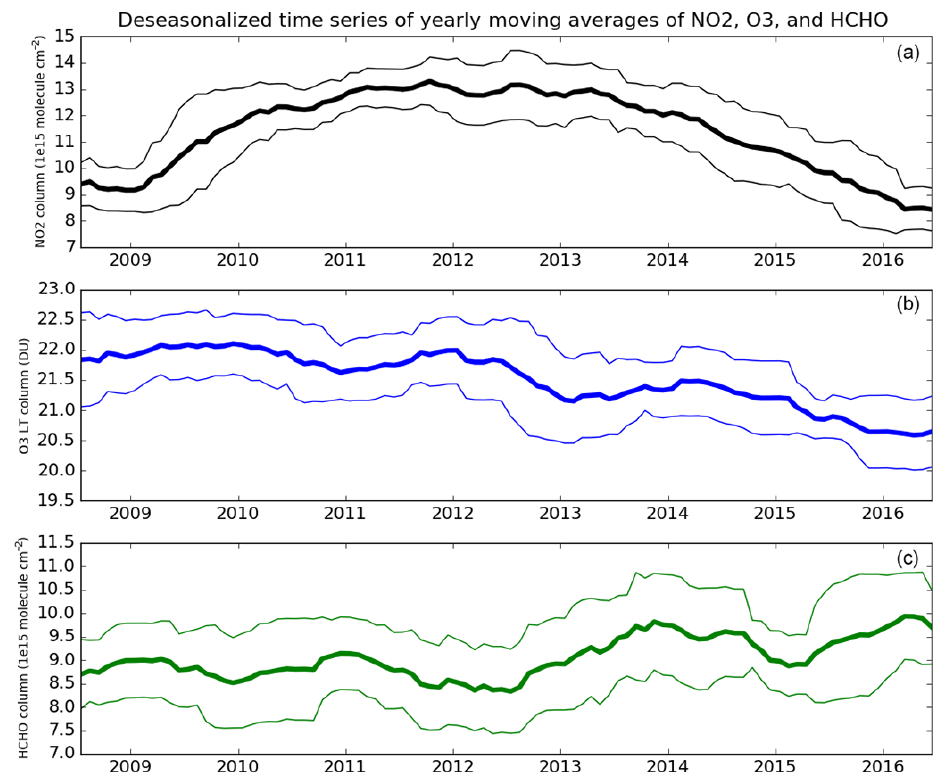
Figure 8. Yearly moving averages of the deseasonalized time series of OMI NO 2 tropospheric columns (a) , IASI LT ozone columns (b) , and OMI HCHO tropospheric columns (c) over the NCP. The thinner lines represent the 1 σ standard deviation range of the moving